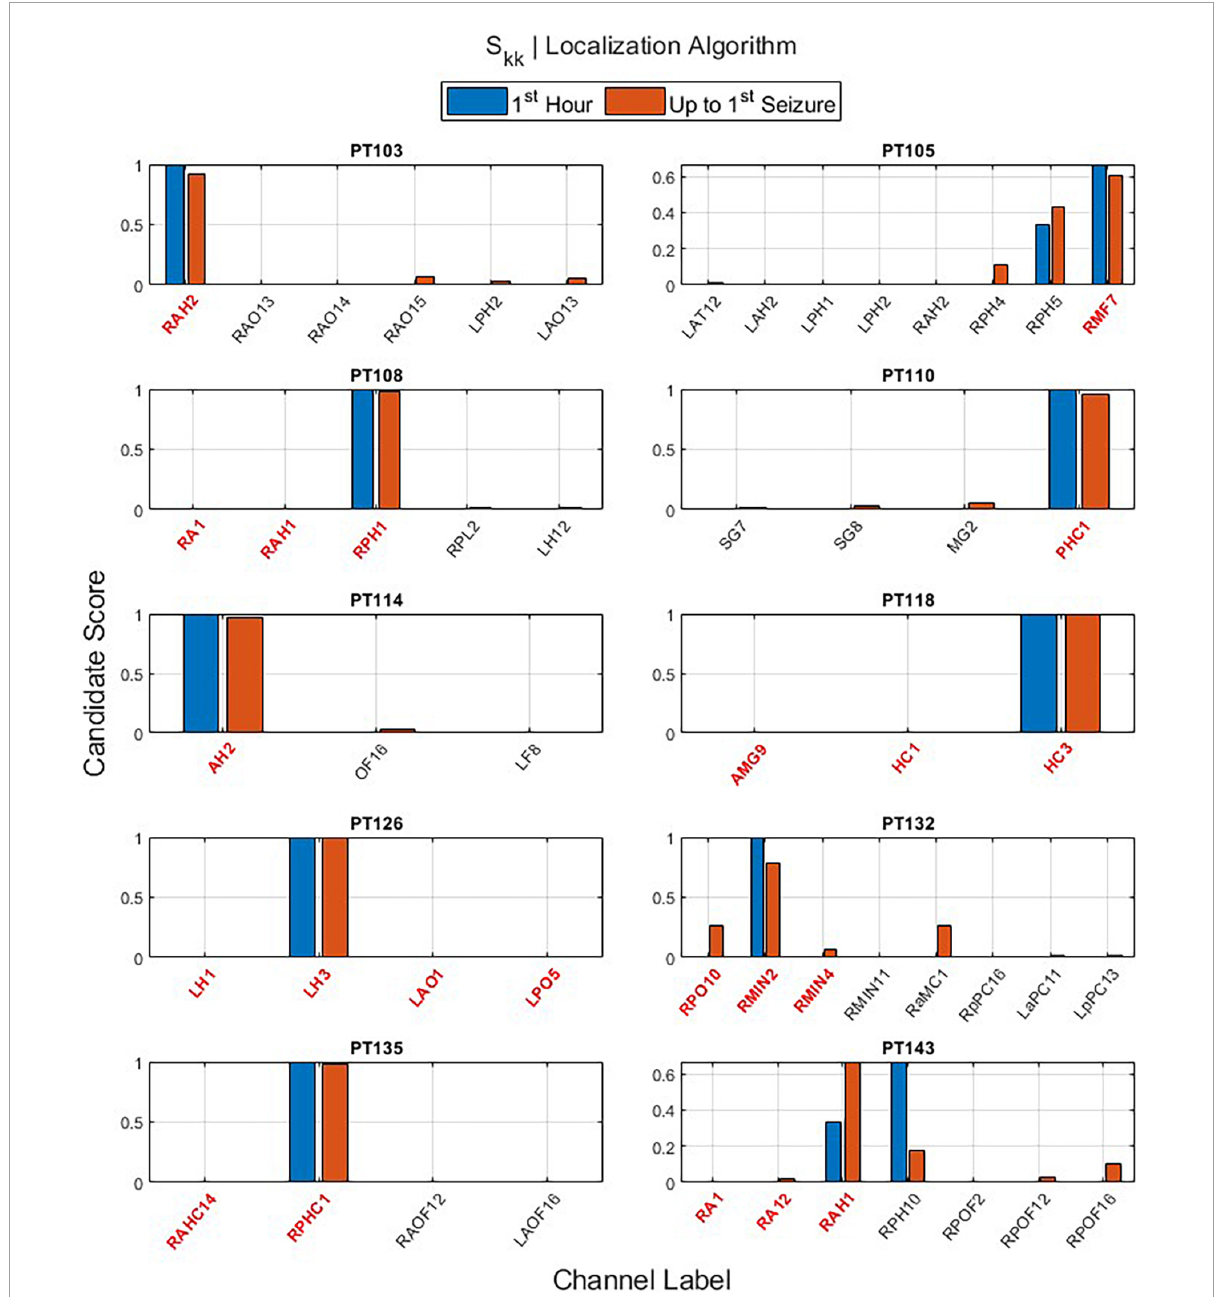
FIGURE7 The output of the EZ interictal localization algorithm (EZILA) per the (10th) patient via the auto-spectra ( S kk ) measure when applied at two times periods: first hour (blue) and up-to-first seizure (brown). Red tick(s) in the channel label axis denote clinically assessed focal channel(s). EZILA was successful in assigning the highest candidate score to one of the clinically assessed focal channel in all the 10 patients at the long time period. Legends: see Figure 6 .